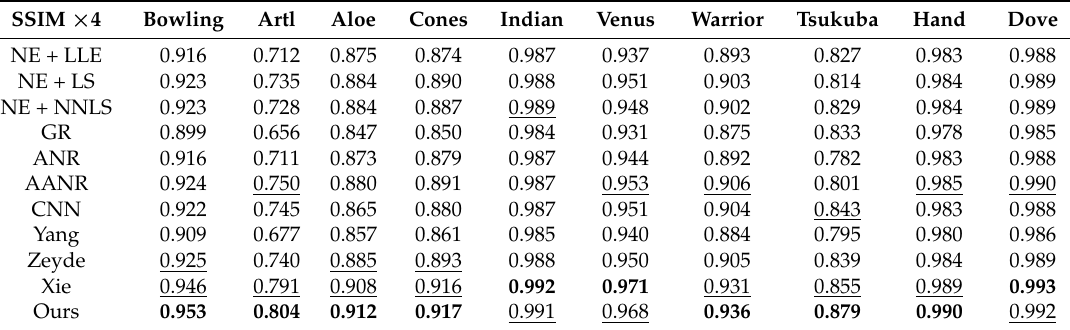
Table 2. SSIM values on the Middlebury Stereo database with scaling factor of 4.